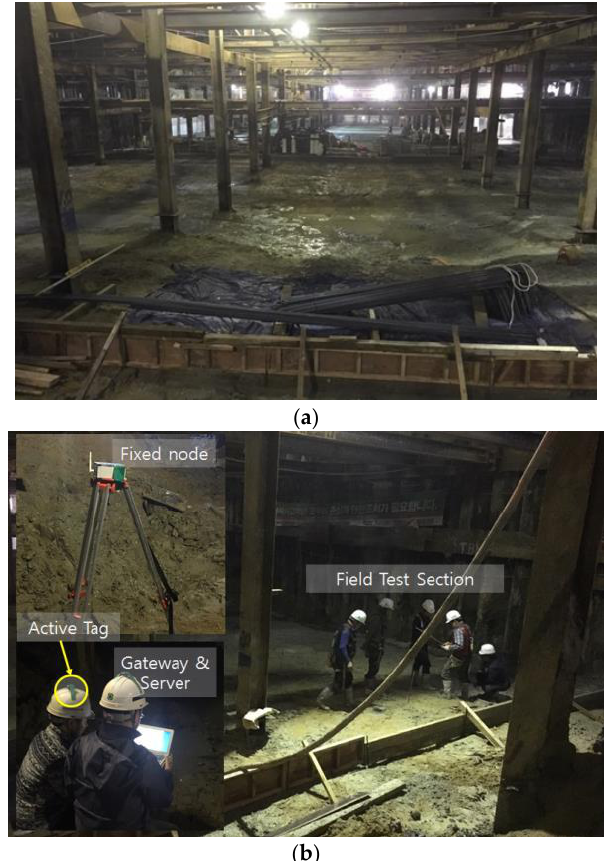
Figure 6. Experimental test in underground construction site: ( a ) Underground construction site; ( b ) Components of RTL system.